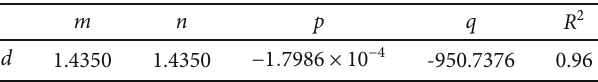
Figure 10: The relationship between the parameter d and parameters T and G Table 7: Fitting parameters for the value of d